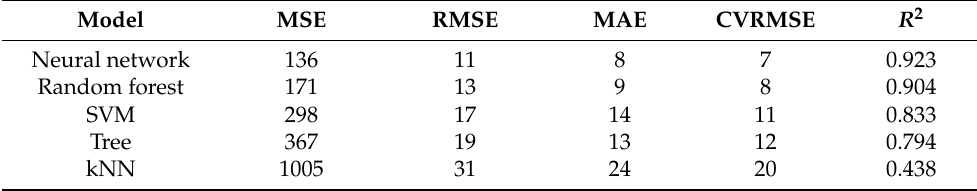
Table 4. Comparison of the learners according to the